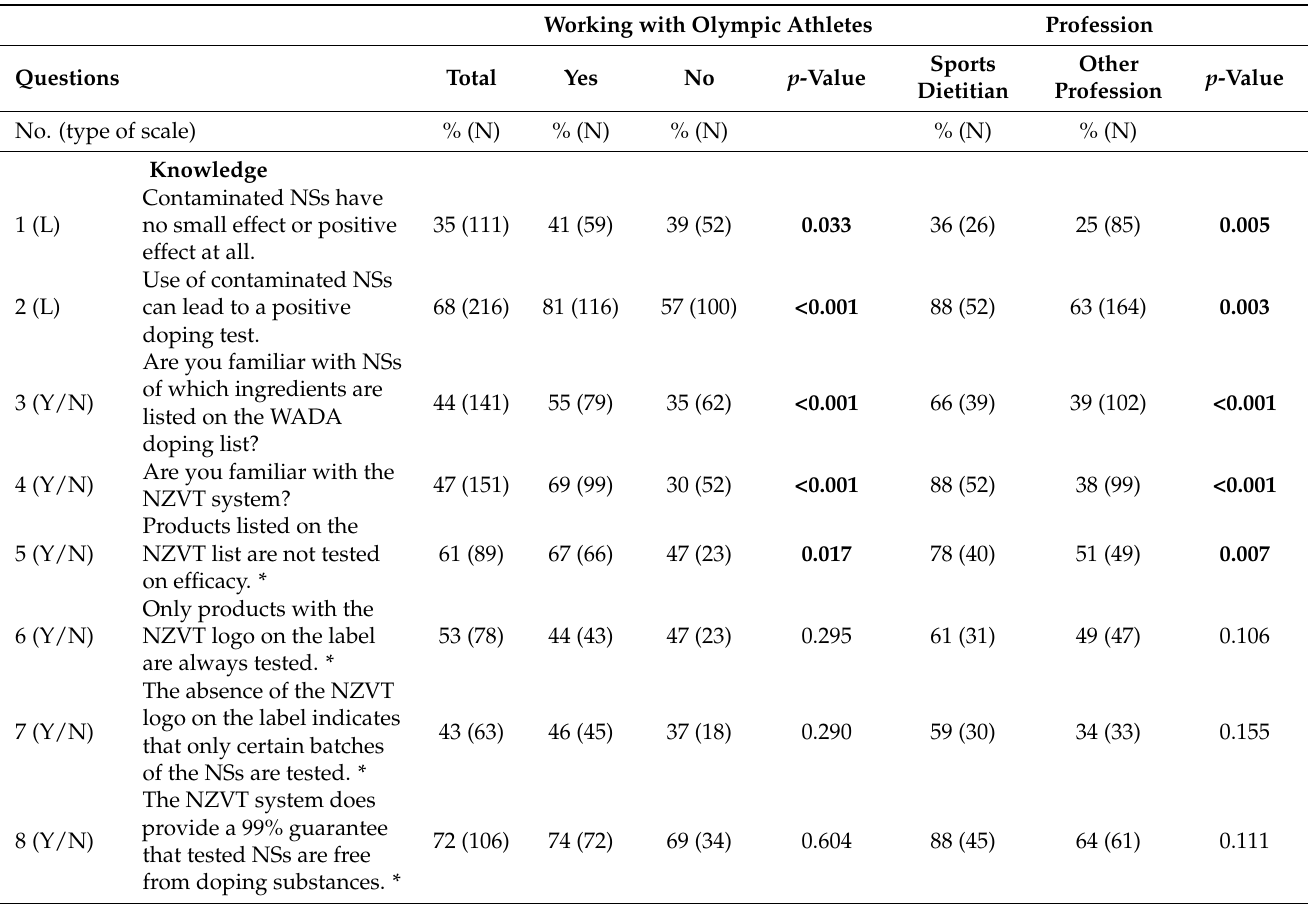
Table 2. Self-reported knowledge about contaminated nutritional supplements (NSs) and dietary supplement third-party testing (% and N) for the total group, professionals working or not working with Olympic athletes, and sports dietitians vs. other